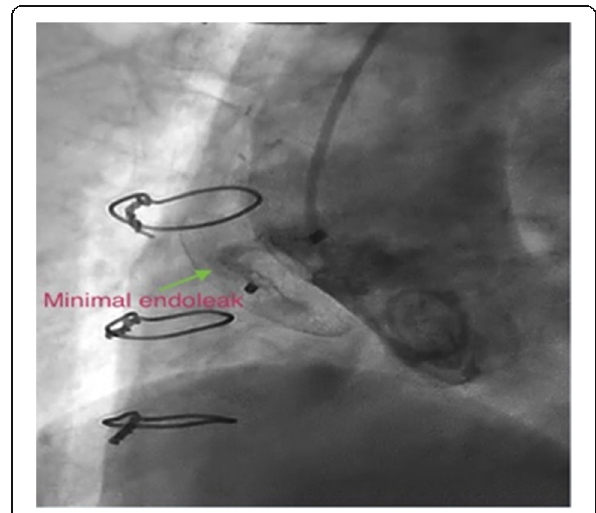
Fig. 7 In final angiogram, a minimal extravasation remained which disappeared in following non-invasive imagings